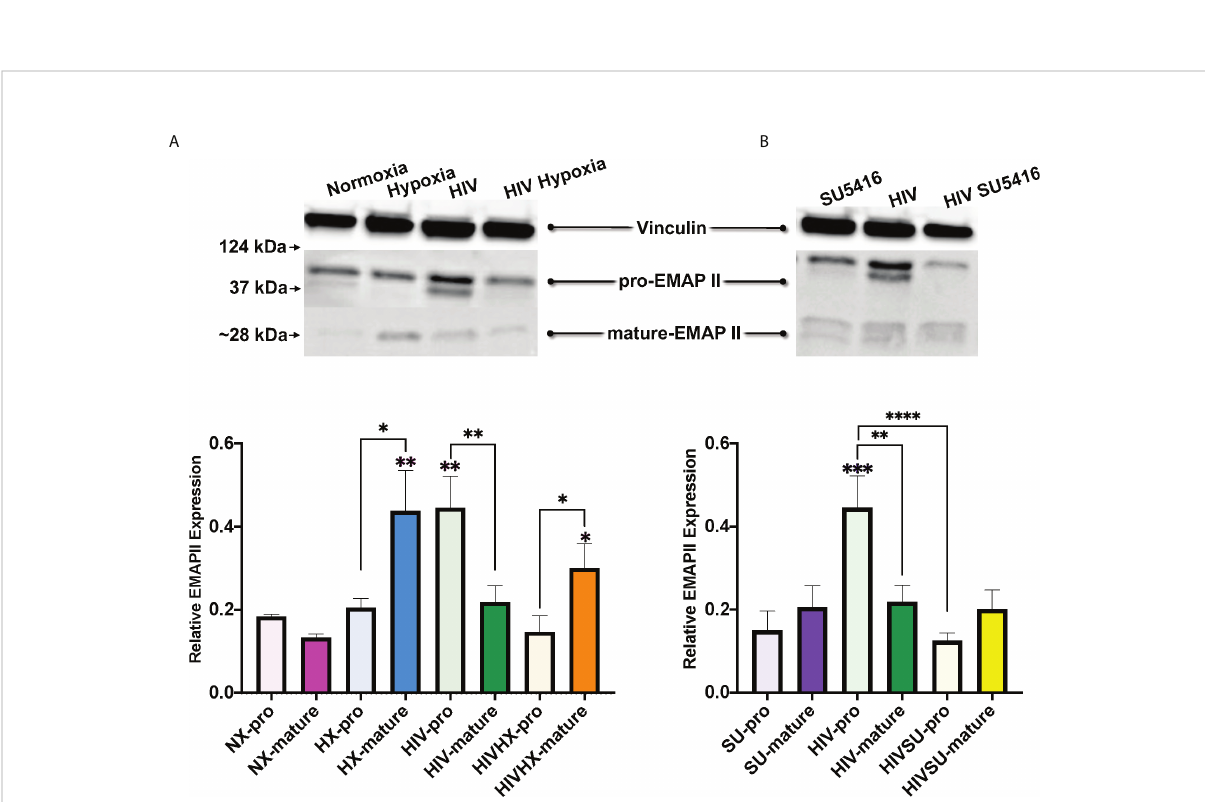
FIGURE 7 Expression of EMAP II in the lungs of HIV-infected mice with humanized immune systems. Blots show bands for housekeeping protein vinculin (124 kDa), pro-EMAP II at 37 kDa and mature-EMAP II at ~28 kDa, as detected by Western blot. Bars show EMAP II expression normalized to vinculin. Panel (A) shows EMAP II dataset comparisons relevant to hypoxia; n=24 mice (5 males, 19 females). Panel (B) shows comparisons relevant to mice treated with SU5416 (Sugen); n=24 mice (4 males, 20 females). Mice in normoxia are shown in pink (NX, n=3); hypoxia in blue (HX, n=3); HIV in green (HIV, n=4); HIV + Hypoxia in orange (HIVHx, n=4); SU5416 in purple (SU, n=4) and HIV + SU5416 in yellow (HIVSU, n=4). Pro-EMAP II is depicted in light colors; darker colors show mature EMAP II. Densitometry analyses were performed using FIJI. Data are represented as mean; SEM. Statistical signi fi cance was tested using independent T tests using the Fisher ’ s LSD without corrections for multiple comparisons as implemented in GraphPad Prism 8. Statistical signi fi cance is indicated as follows: *,p<0.05; **p<0.01; ***p<0.001;